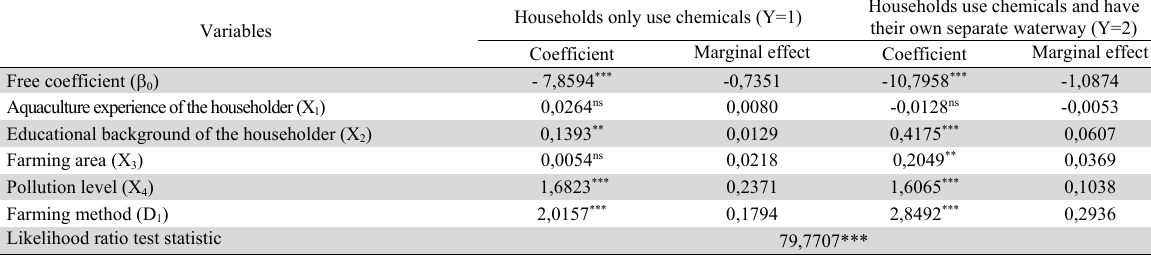
Determinants influencing the application of environmental